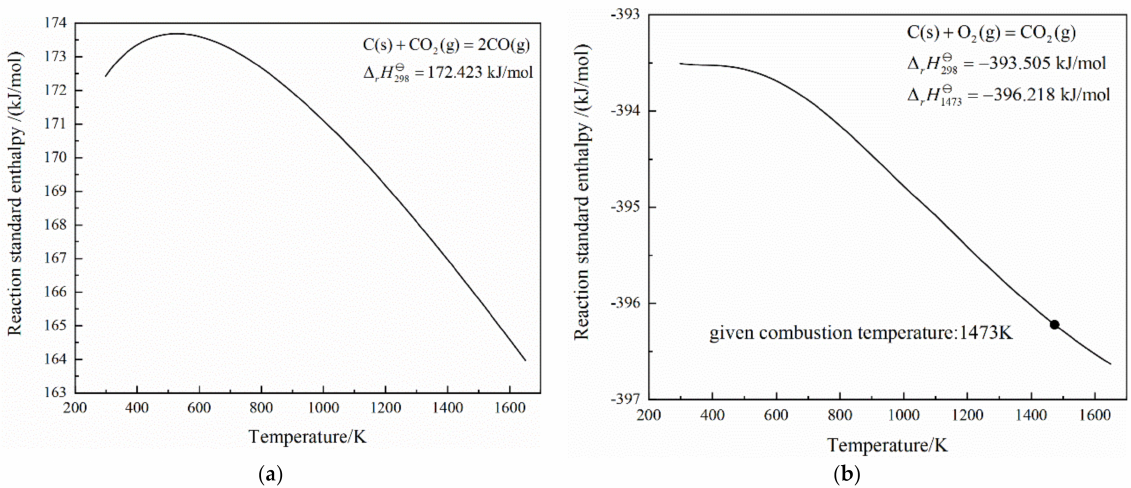
Figure 8. The standard reaction enthalpy as a function of temperature: ( a ) the reaction of C(s) + CO 2 (g) = 2CO(g); ( b ) the reaction of C(s) + O 2 (g) = CO 2